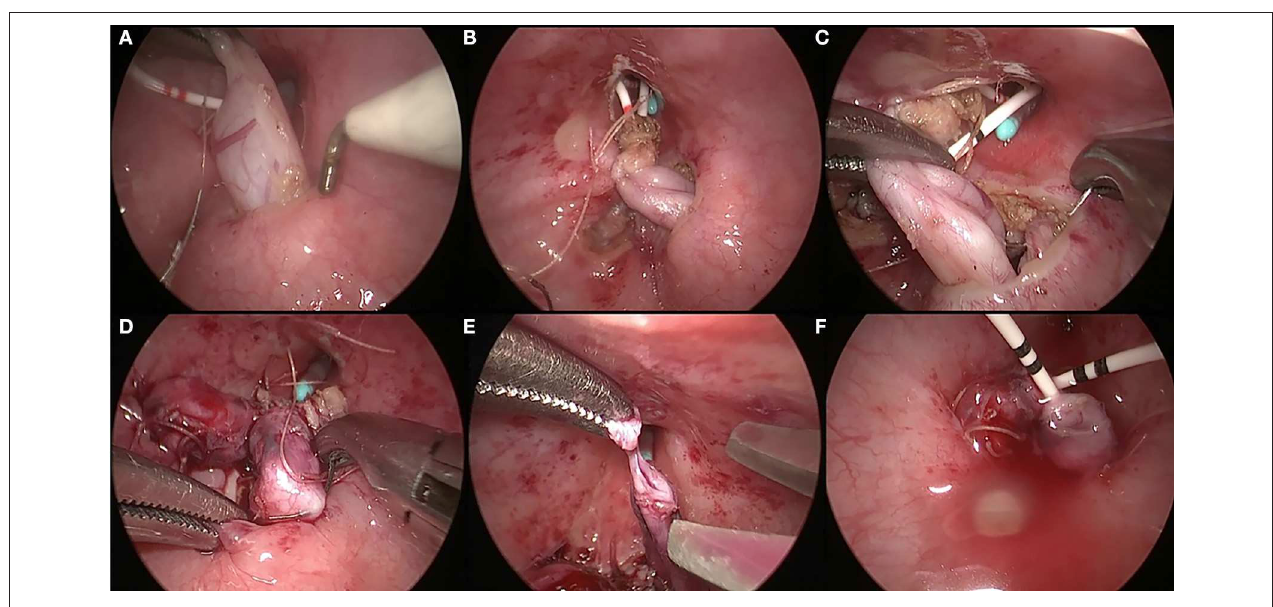
FIGURE 1 | Surgical procedures of pneumovesicoscopic-modified ureteral orthotopic reimplantation. The distal ureter was progressively dissected free from the bladder wall until the dilated proximal segment (A) . The free segment of the ureter was dragged into the bladder for 4–5cm and suspended on the contralateral bladder wall (B) . The muscle of the bladder was sutured to the ureteral seromuscular layer using 5-0 absorbable interrupted sutures (C) . The bladder mucosa was sutured to the ureteral seromuscular layer using 5-0 absorbable interrupted sutures (D) . The distal lesion segment was excised at the transitional segment of the ureter (E) . The proximal dilated ureter protruded into the bladder for 2–2.5cm at the original position and became the neo-orifice with a double J stent in the ureter (F) .